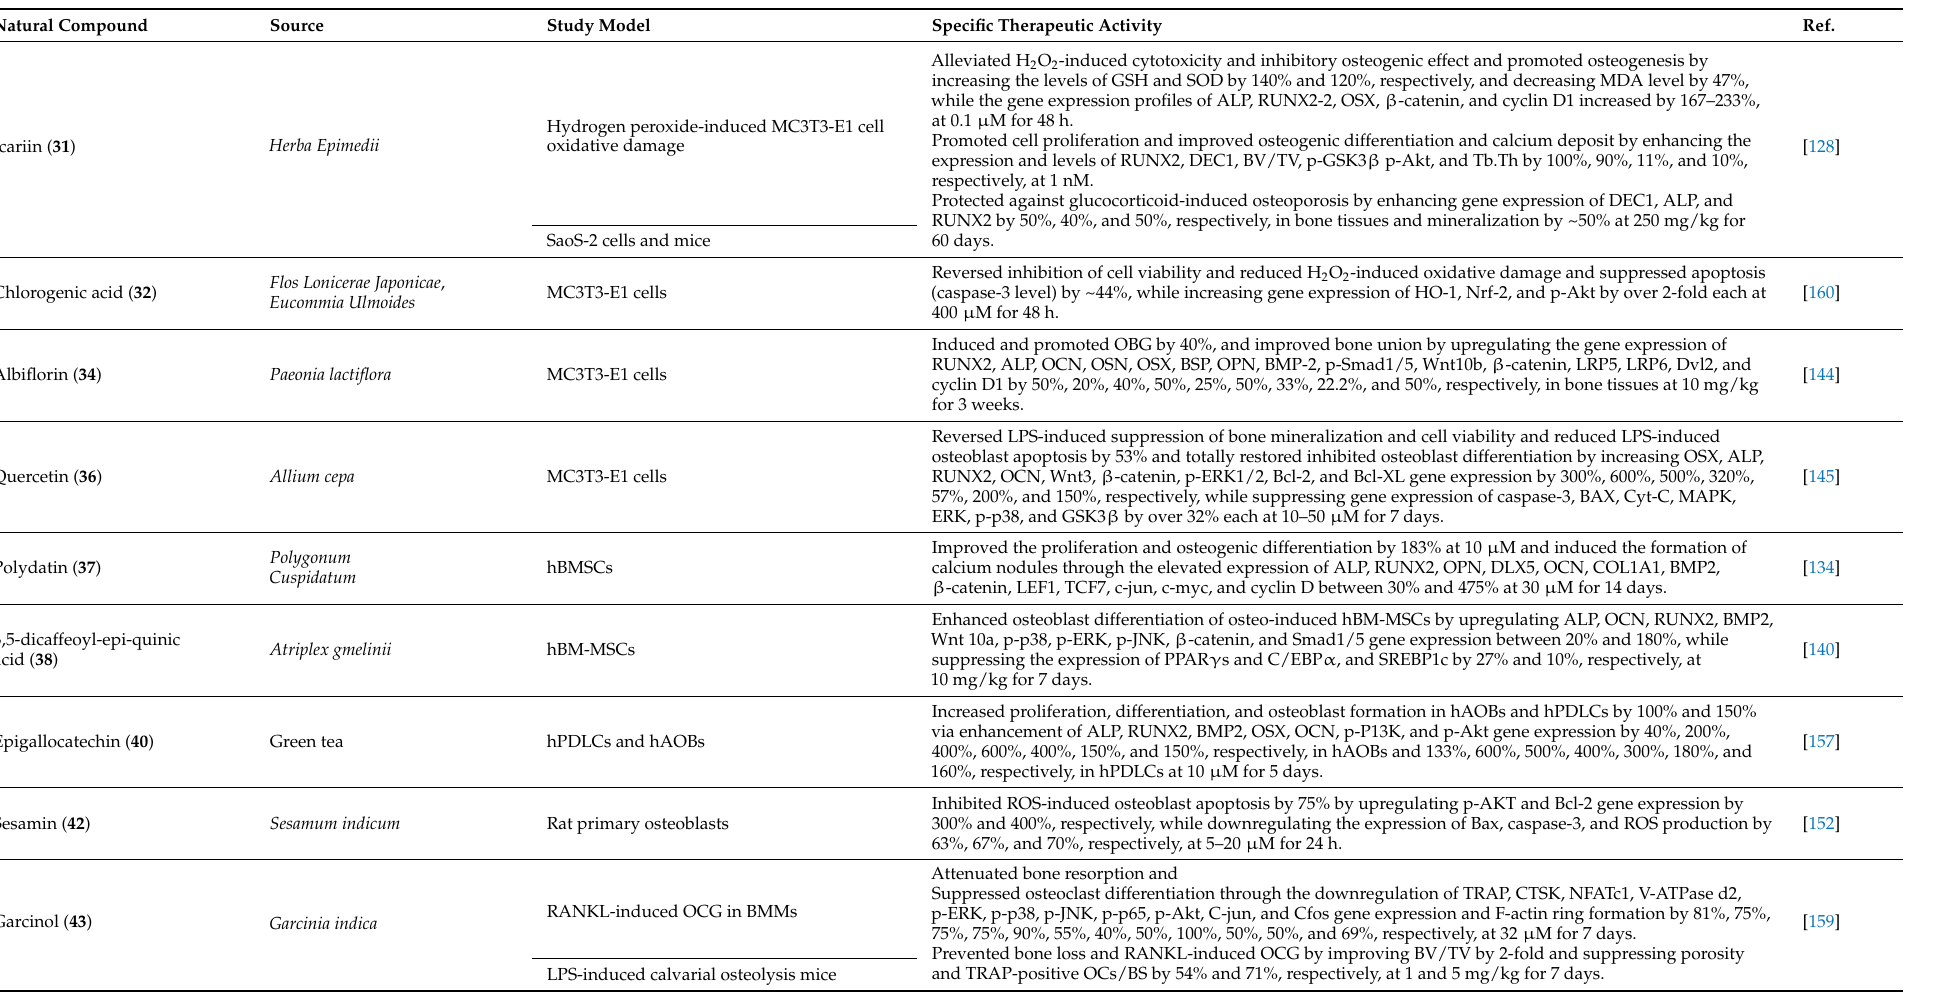
Table 2. Natural compounds with osteoprotective properties via BMP2-Wnt/ β -catenin and PI3K/Akt/GSK3 β signaling